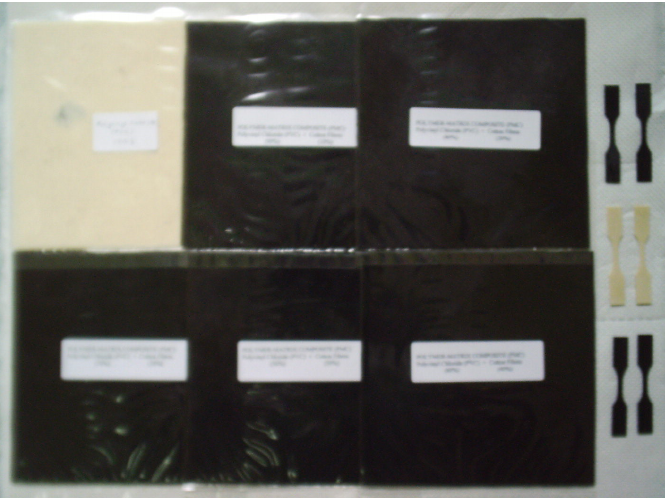
Figure 2. Set of pressed PVC specimens.